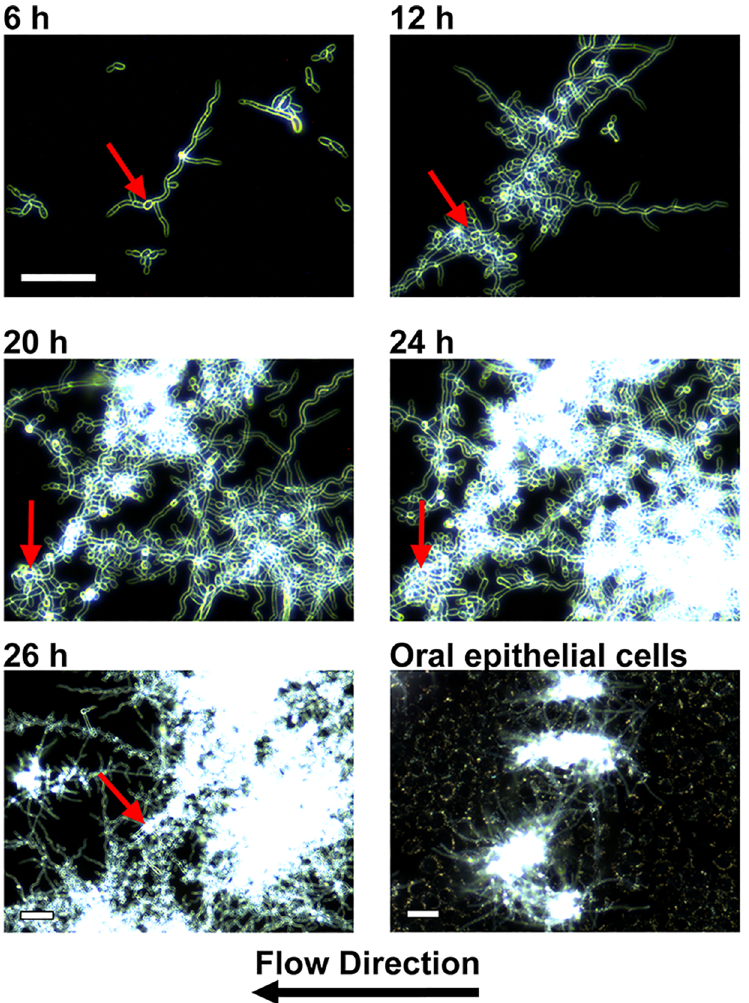
Fig 1. C . albicans forms microcolonies under continuous flow conditions. Wild-type Candida albicans cells were grown on plastic or epithelial monolayers under continuous flow at 37˚C and imaged at indicated times using darkfield microscopy. Red arrows indicate the position of the originating mother cell in each image. Scale for upper four images is identical. Scale bars indicate 100 μ m.